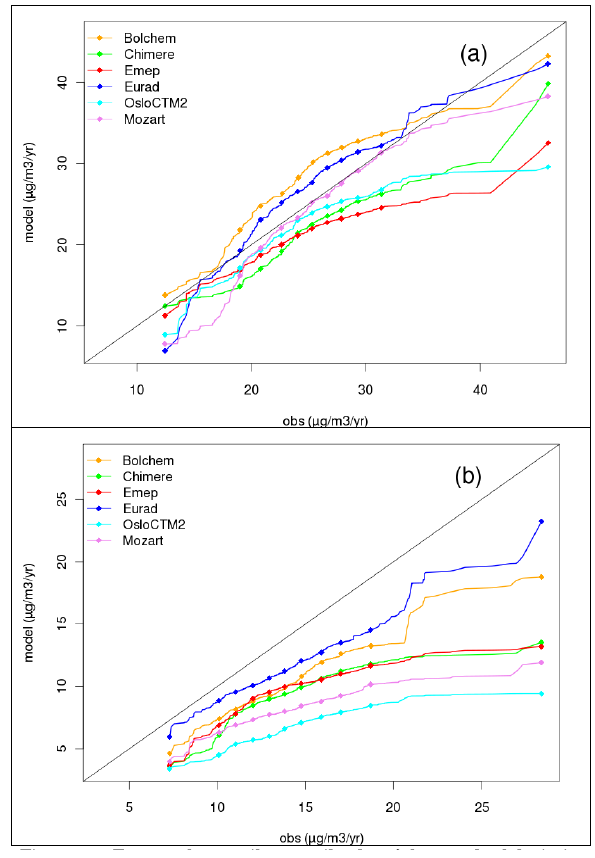
Figure 13 : Top panel: quantile-quantile plot of the standard deviation of the residuals of monthly mean O 3 , once the linear trend has been removed, observations (x-axis) being used as a reference. In the bottom panel, the seasonal cycle has also been removed. The dots indicate the percentiles by multiples of 10 (0, 10 th , 20 th , …, 100 th ).